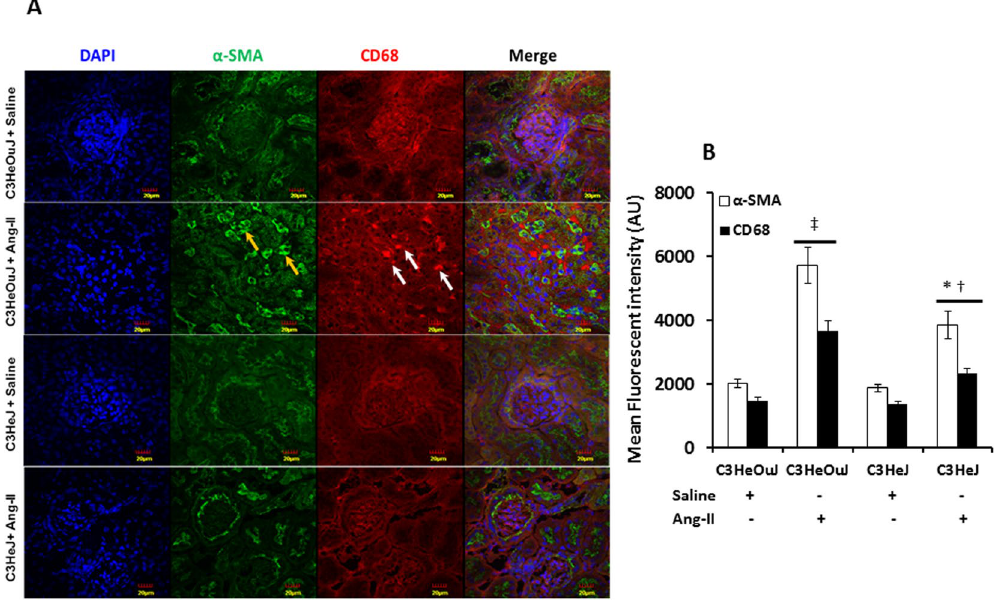
Figure 11. The expression of α -SMA and CD68 is decreased in mice with TLR4 deficiency. ( A ) Representative immunofluorescence image for fibroblast marker, α -SMA and CD68, a marker for inflammatory macrophage. The α -SMA (yellow arrows) and CD68 (white arrows) expression is increased in tubulo-interstitial areas in mice with normal TLR4 to Ang-II treatment. ( B ) Data is presented as mean fluorescent intensity ± SEM. n = 5/group, tested by Kruskal-Wallis test and Mann-Whitney rank sum test. Magnification × 60. Scale bar: 20 µ m. * p < 0.05 vs. C3HeJ + saline, † p < 0.05 vs. C3HeOuJ + Ang-II, ‡ p < 0.05 vs. C3HeOuJ + saline. C3HeOuJ: normal TLR4, C3HeJ: TLR4